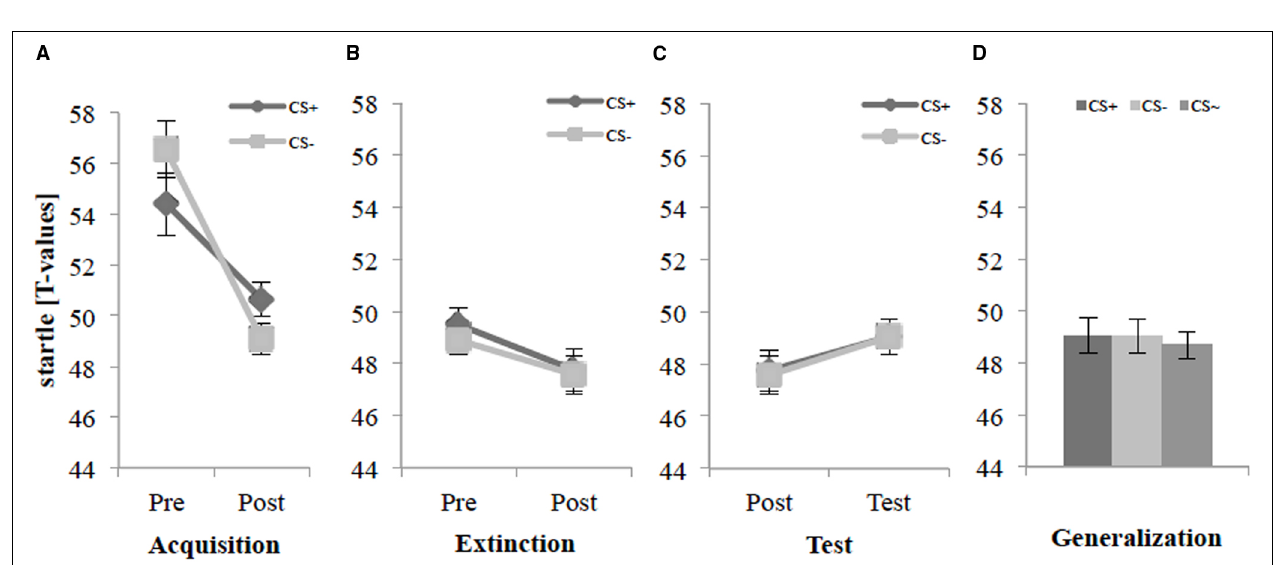
FIGURE 4 | Fear-potentiated startle ( n = 32) for CS + and CS (cid:0) pre and post acquisition (A), extinction (B), and test phase (C) as well as the generalization effect (D) for CS + , CS (cid:0) , and CS (cid:24) during test phase. Note: CS + , agents with aversive unconditioned stimulus (US); CS (cid:0) , agents